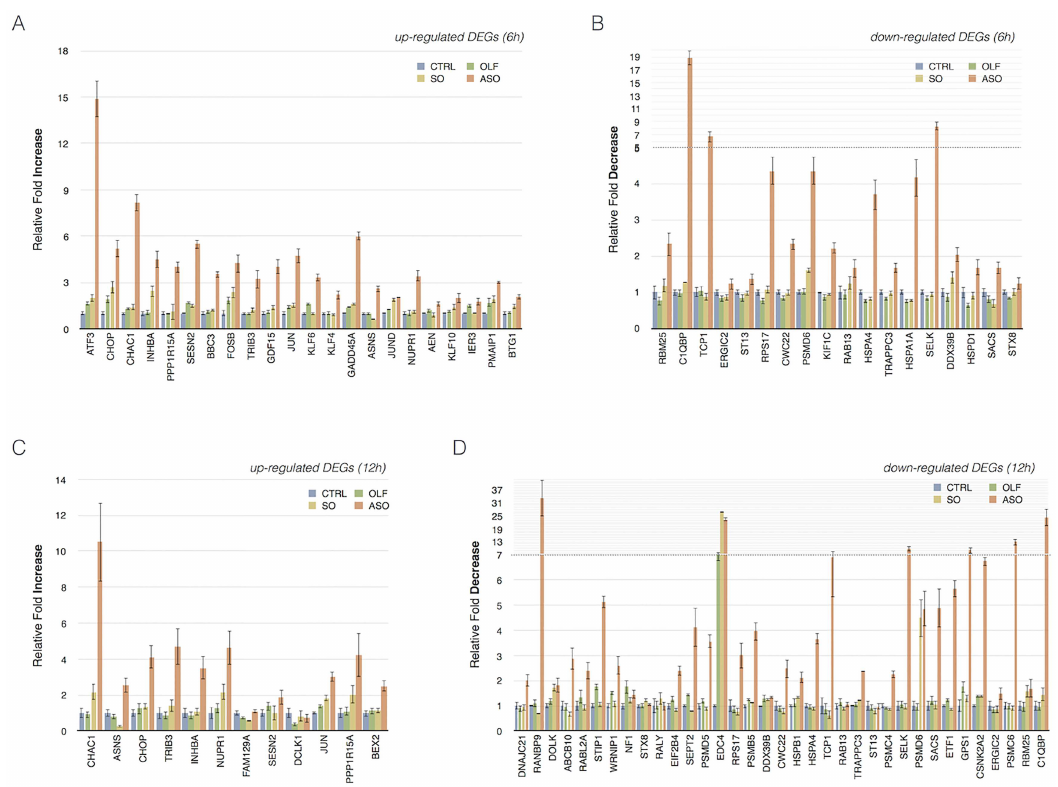
Fig 5. qPCR verification of DEGs. Graphs show relativefold change values of up-regulation (A and C) and down regulation(B and D) of selectedgenes. The results, normalized to β -actin, were averaged from values obtainedby performing three technicalreplicates.The values are means ± SD.